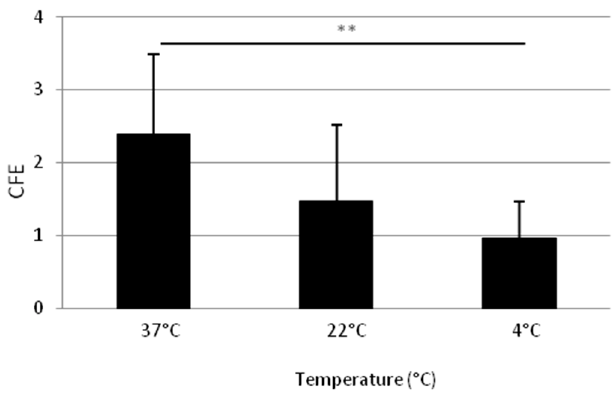
Figure 4. Influence of adhesion temperature on the clonogenic potential of isolated cellular suspension (RA and LA). CFE obtained for RA cells after detachment of cells having adhered for 10 min on collagen I at different temperature. Mean of three donors. n = 3. ** data significantly different p < 0.005.